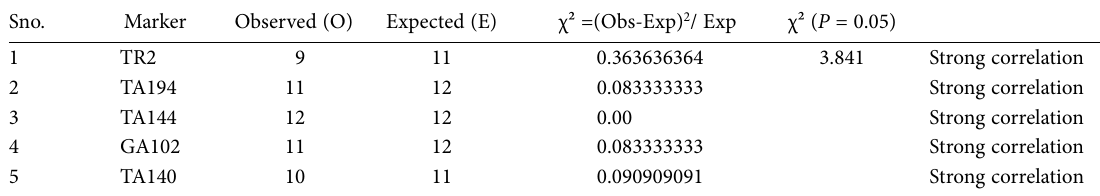
Low χ² values indicate strong correlation with resistant